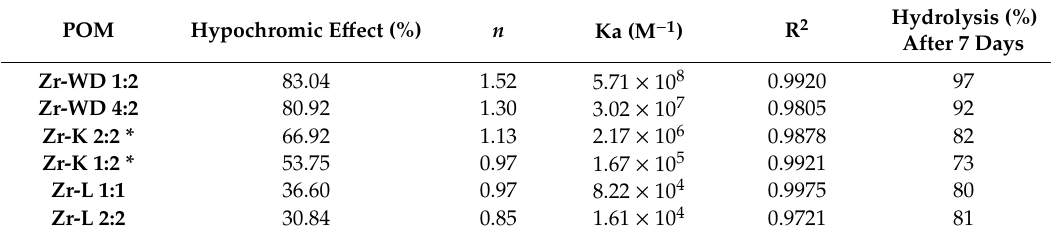
Table 2. Calculated values of association constant (K a ), the number of bound molecules ( n ), the percentage of hypochromic effect and percentage of hydrolyzed protein.